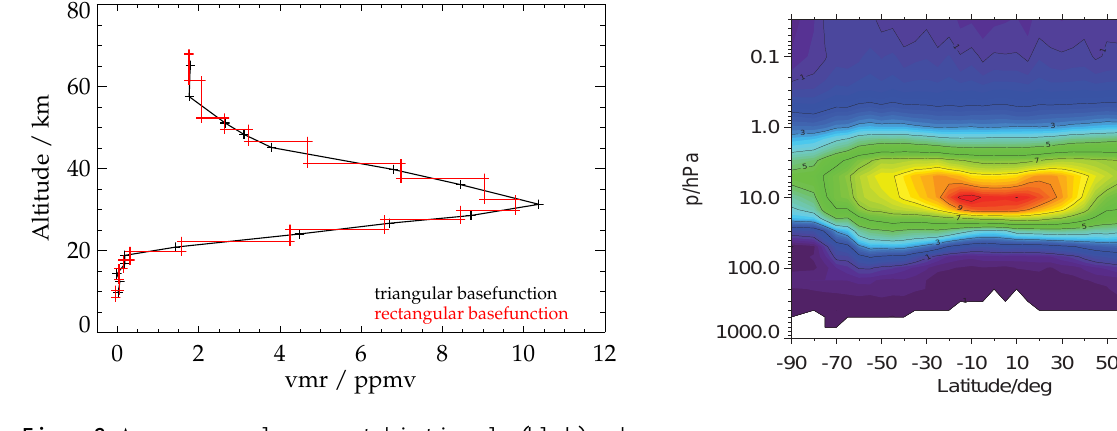
Figure 2. An ozone profile represented in triangular (black) and rectangular (red) base functions.